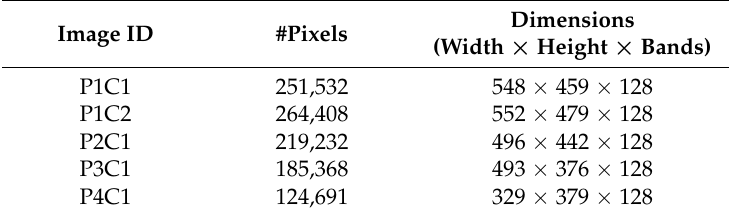
Figure 2. Example of an in-vivo HS human brain image dataset employed in the study (P2C1). ( A ) Synthetic RGB representation of the HS cube; ( B ) Supervised classification map obtained using the SVM classifier; ( C ) One-band representation of the HS cube obtained employing PCA algorithm. Table 1. HS brain cancer image